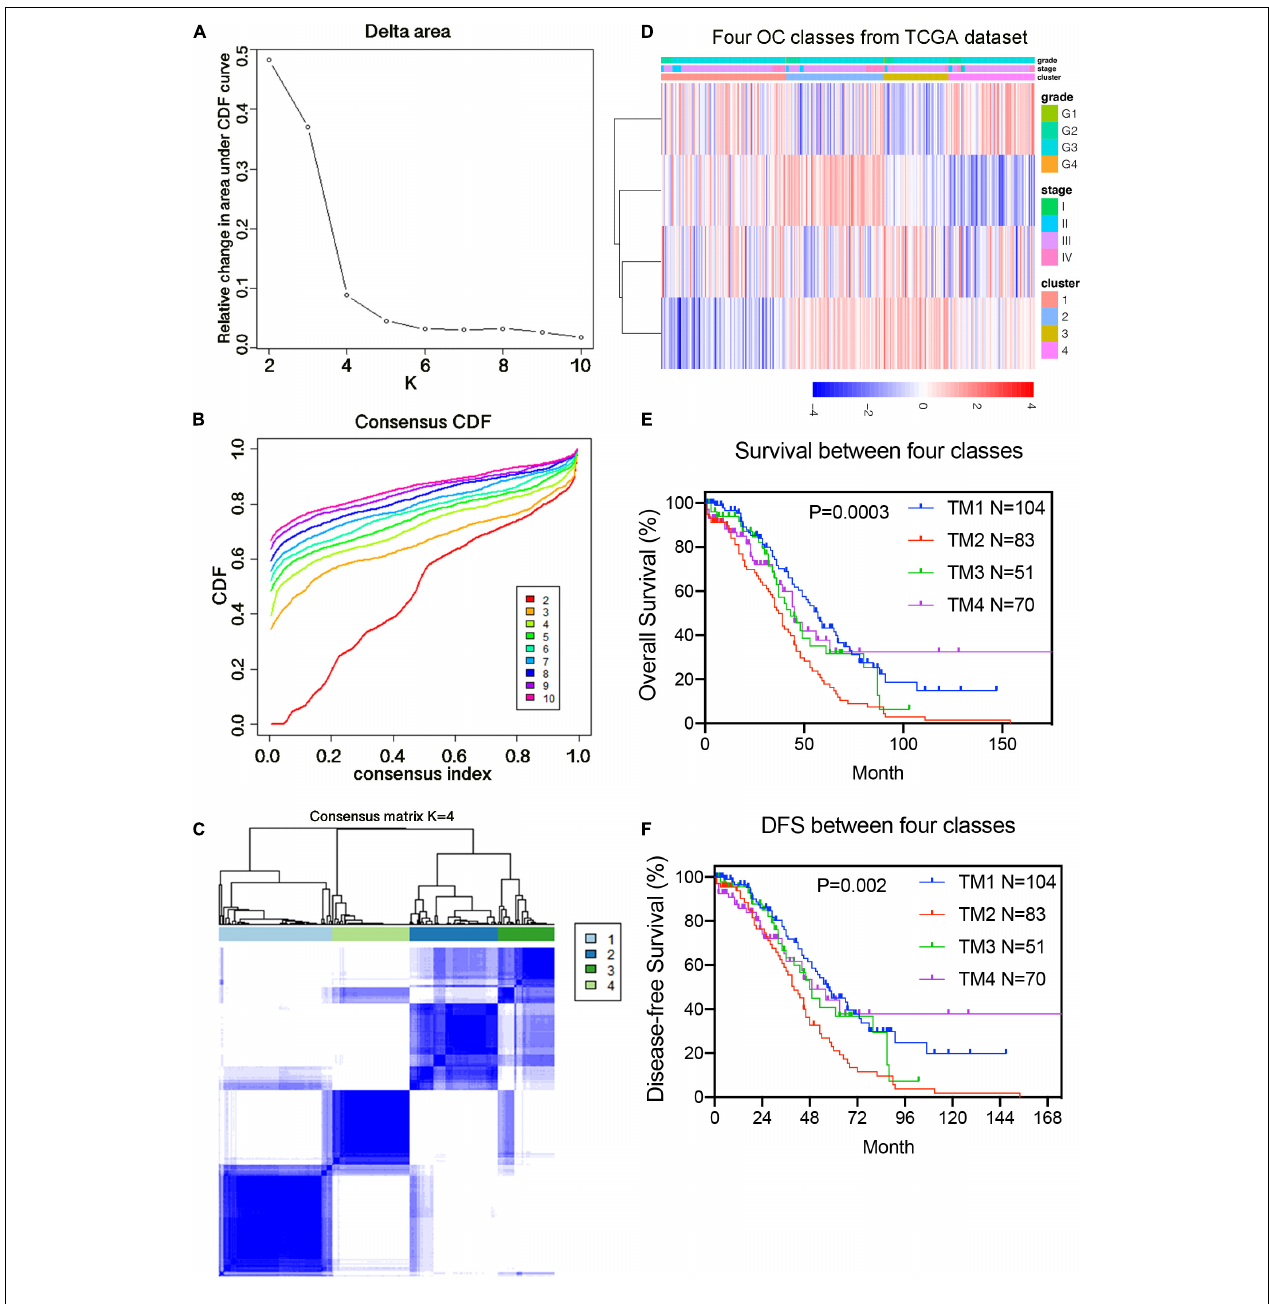
FIGURE 4 | Identification of consensus clusters by 4 prognostic genes. (A) Relative change in area under CDF curve for k = 2–10 classified by the prognostic risk model. (B) Consensus clustering cumulative distribution function (CDF) for k = 2–10 classified by the prognostic risk model. (C) Consensus clustering matrix for k = 4. (D) Heat maps and significant clinical features of the four subgroups. (E) Kaplan–Meier overall survival (OS) curves for 308 samples in the four subgroups classified by 4 prognostic genes. (F) Kaplan–Meier disease-free survival (DFS) curves for 308 samples in the four subgroups classified by four prognostic